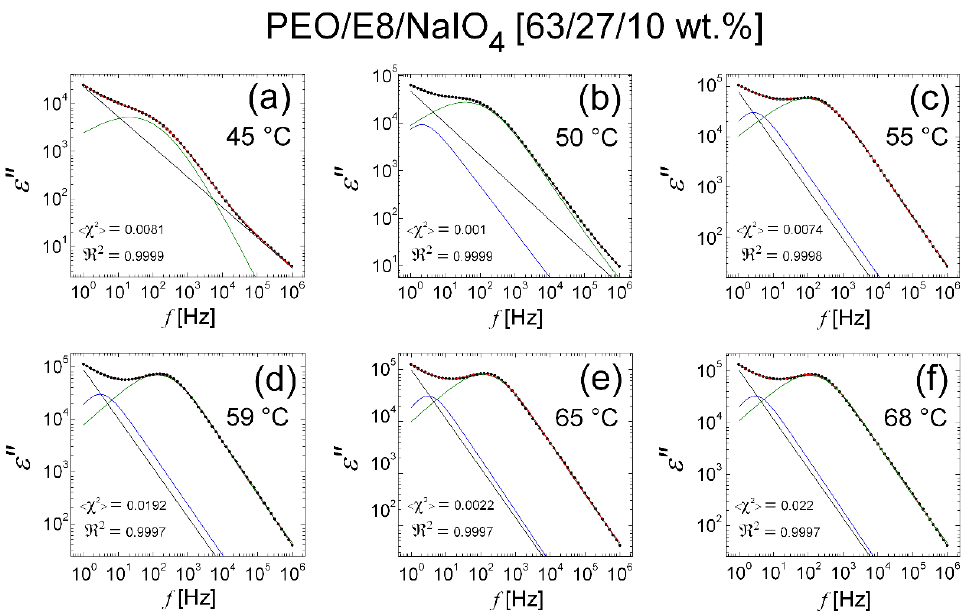
Figure 18. Fits on the ε ″ ( f ) spectra of PEO/E8/NaIO 4 using Equation (3). The ε ″ ( f ) spectra correspond to temperature range of 45 °C to 68 °C: 45 °C ( a ); 50 °C ( b ); 55 °C ( c ); 59 °C ( d ); 65 °C ( e ); 68 °C ( f ). The ε ″ spectral data are represented by the symbol (X); the blue and the green lines of the best fits on the ε (cid:48)(cid:48) data are the contributions of the two HN functions in the ε (cid:48)(cid:48) term; the straight line represents the contribution of the conductivity term; the envelope of the three spectral components’ curves (the total fit) is colored in red. The values of the reduced < χ 2 > factor (the coefficient of determination of fit), as well as the regression coefficient (the goodness of fit), are also